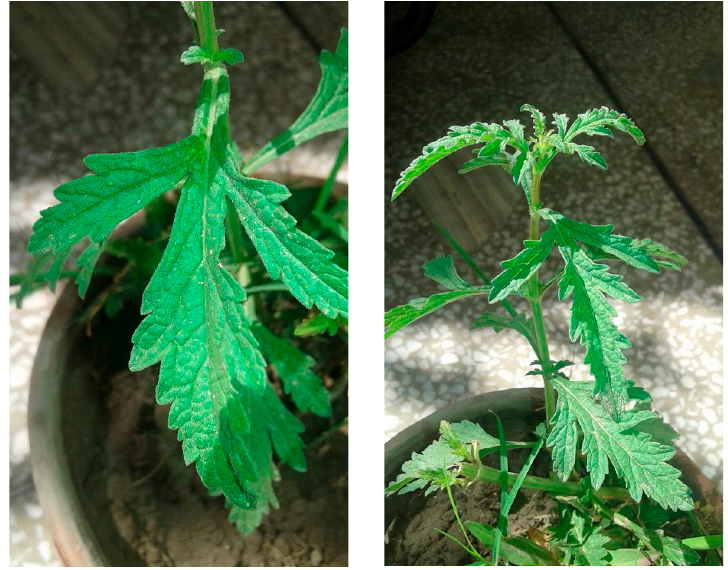
Figure 2. Verbena officinalis (06-21-2018, Chak NO. 363 JB, Tehsil Gojra, District Toba Tek Singh, Division Faisalabad 56000).